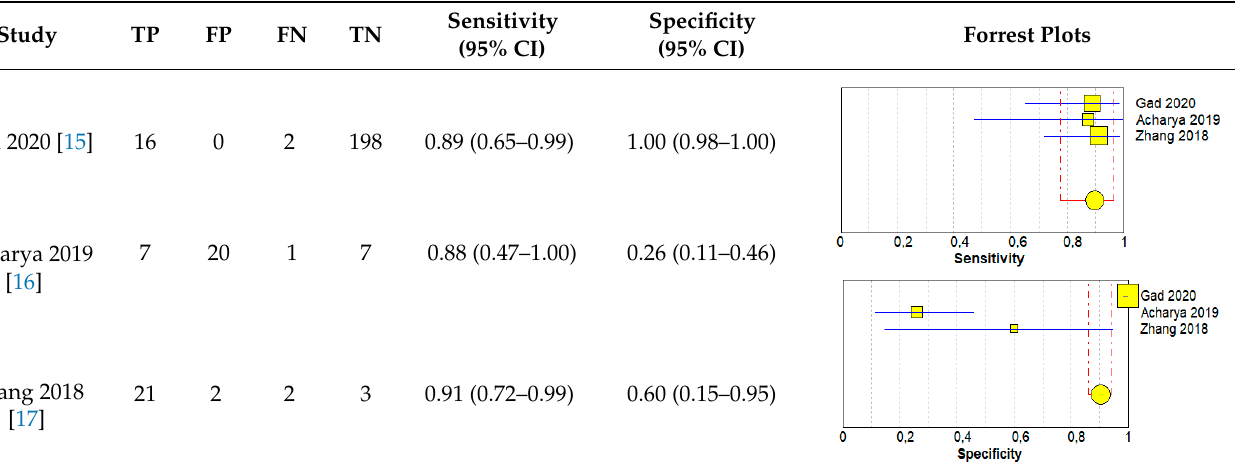
Table 3. Forest plot showing sensitivity and specificity for each included study.